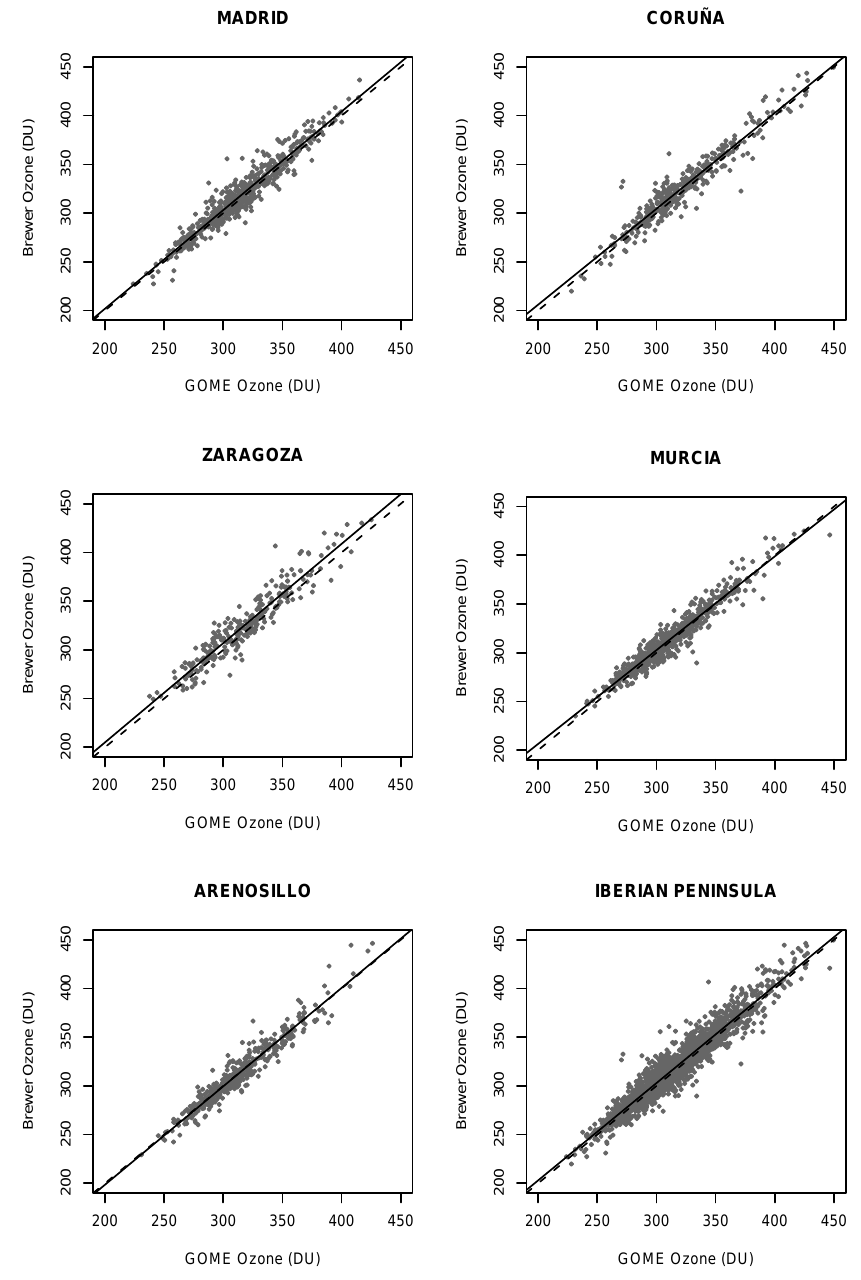
Fig. 2. Ozone amount measurements of Brewer spectrophotometer versus GOME satellite observations. Regression line (solid line) and unit slope (dashed